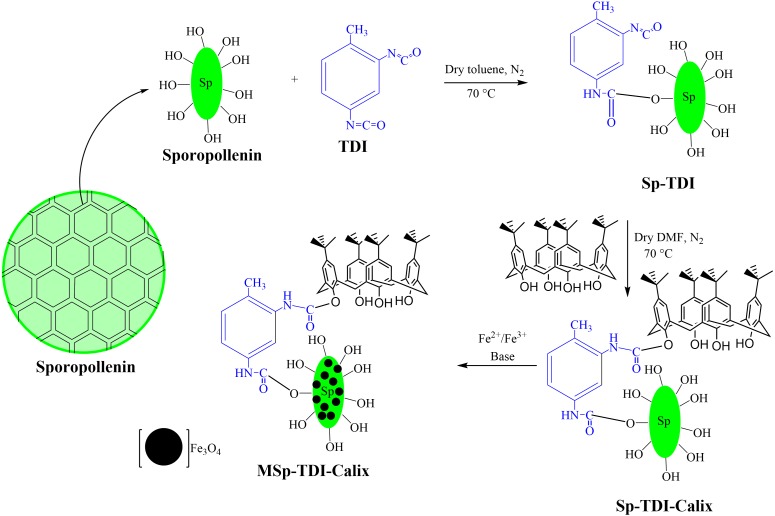
The synthesis pathways of MSp-TDI-calix adsorbent.